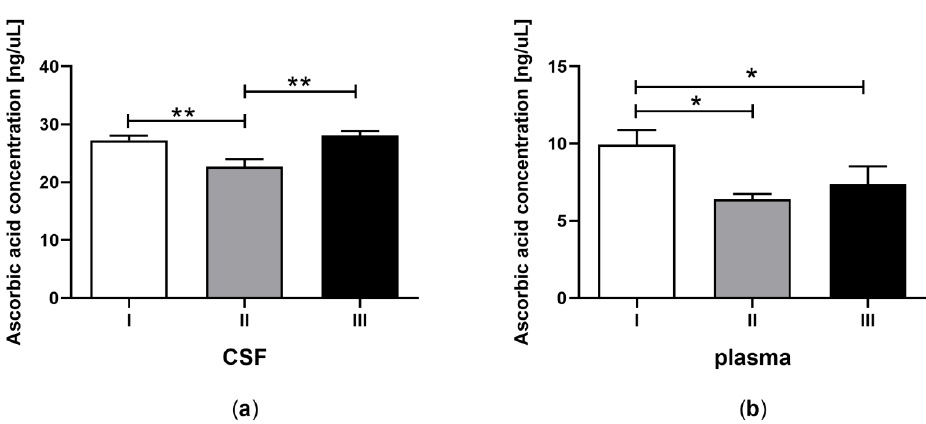
Figure 2. Ascorbic acid concentration in CSF (a) and plasma (b) of the patients in MCS before (white bars) and after first (grey bars) and second (black bars) transplantation of BM-MSC. The statistical analysis was determined by a one-way ANOVA followed by Tukey’s multiple comparison test ( p < 0.05). Asterisks indicate differences in the antioxidant capacity between examining groups (* p < 0.05; ** p < 0.001).